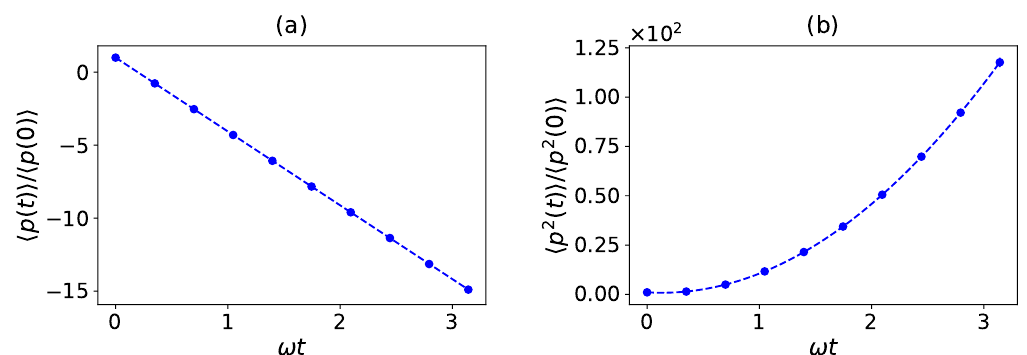
Figure 3: Time evolution of the first and second moment of the ˆ p -operator for a Gaus- sian wavepacket with σ = 0.5, k = 1.0, a = 0.5 and evolving according to Eq. (1) with λ = 0.2 in the commuting limit. The dashed line is computed by integrating numerically the Schrödinger equation with the Crank-Nicholson method [ 60 ] with lattice spacing ∆ x = 6 × 10 − 4 and time step ∆ t = π × 10 − 4 . Blue dots are computed with the stochastic method with ∆ t = 10 − 4 , and by sampling N = 1.2 × 10 6 Gaussian random numbers. Error bars, corresponding to the statistical standard deviation over the sampling average, are not visible on the scale of the